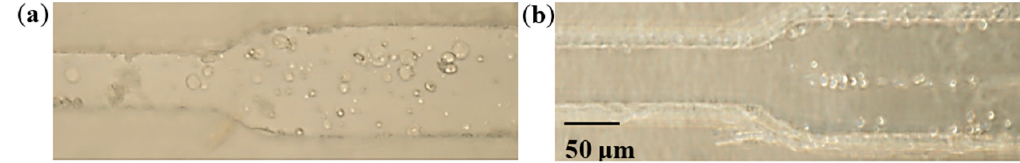
Figure 10. The distribution of microparticles in the microchannel ( a ) before, and ( b ) after, the activation of the SSAW.